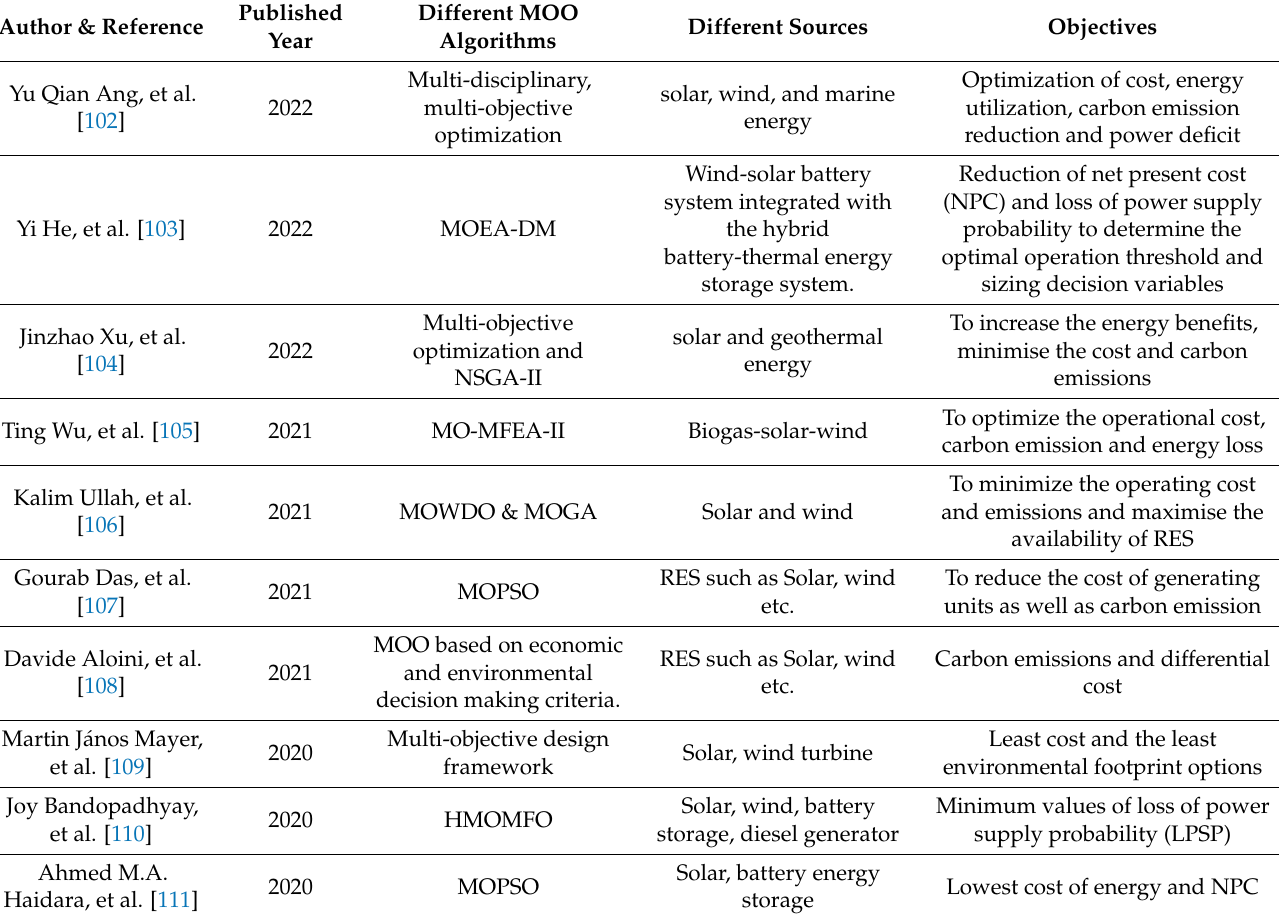
Table 2. Literature review on MOO with evolutionary